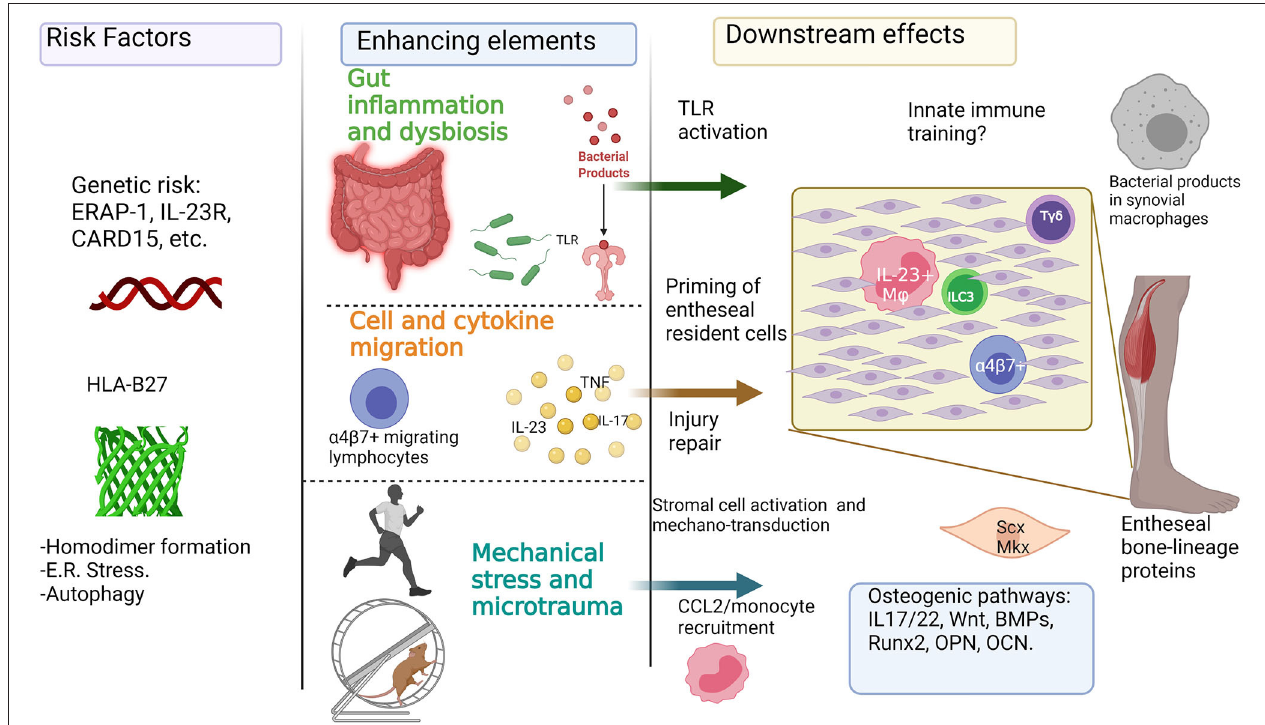
FIGURE 5 | Inflammatory and mechanical factors in the onset of enthesitis: Genetic predisposition for enthesitis can be represented by HLA-B27 and its role in the endoplasmic reticulum (E.R.) stress, autophagy, and homodimer formation, and also by other polymorphisms in genes like ERAP-1 and IL-23R. Further enhancing elements involved in the onset of enthesitis include the role of the “leaky gut” syndrome, intestinal dysbiosis, and the activation of gut-homing lymphocytes. Additionally, mechanical stress can play a key role in enhancing inflammation and osteoproliferation through injury repair mechanisms, production of chemokines like CCL2, and the activation of stromal cells like tenocytes. The previous can be added to the potential role of osteogenic pathways like Wnt, BMP, and Runx2. This figure was done with biorender (Biorender.com)